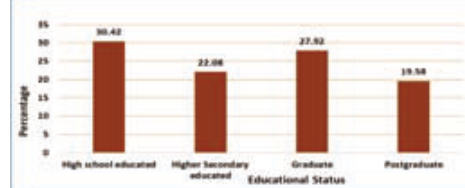
Personal Profile